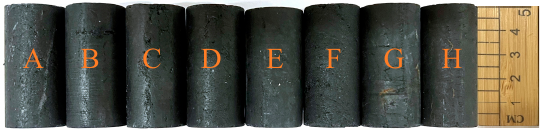
Figure 3. Coal samples: sample A; sample B; sample C; sample D; sample E; sample F; sample G; sample H.